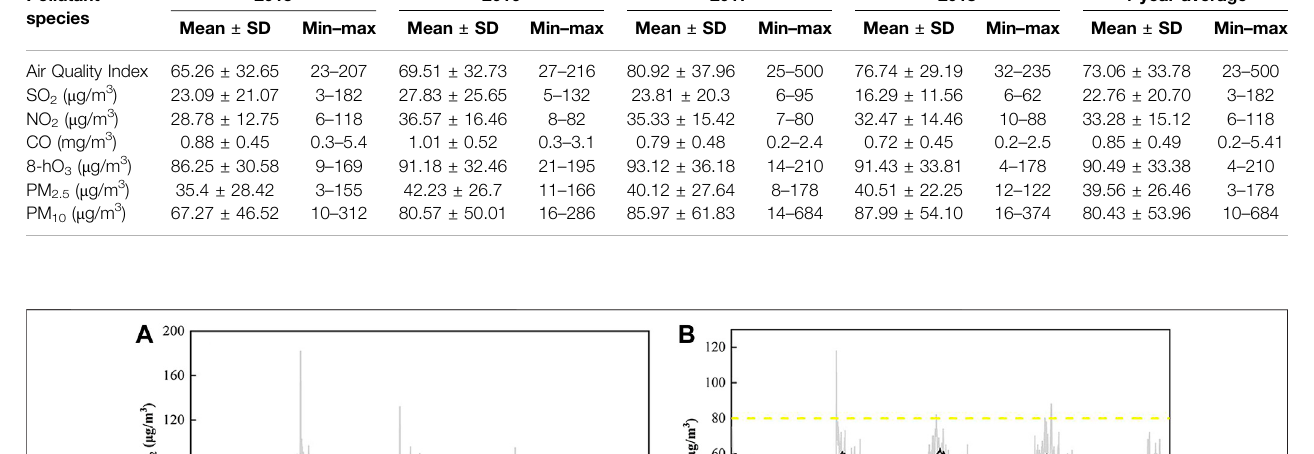
Frontiers in Earth Science |